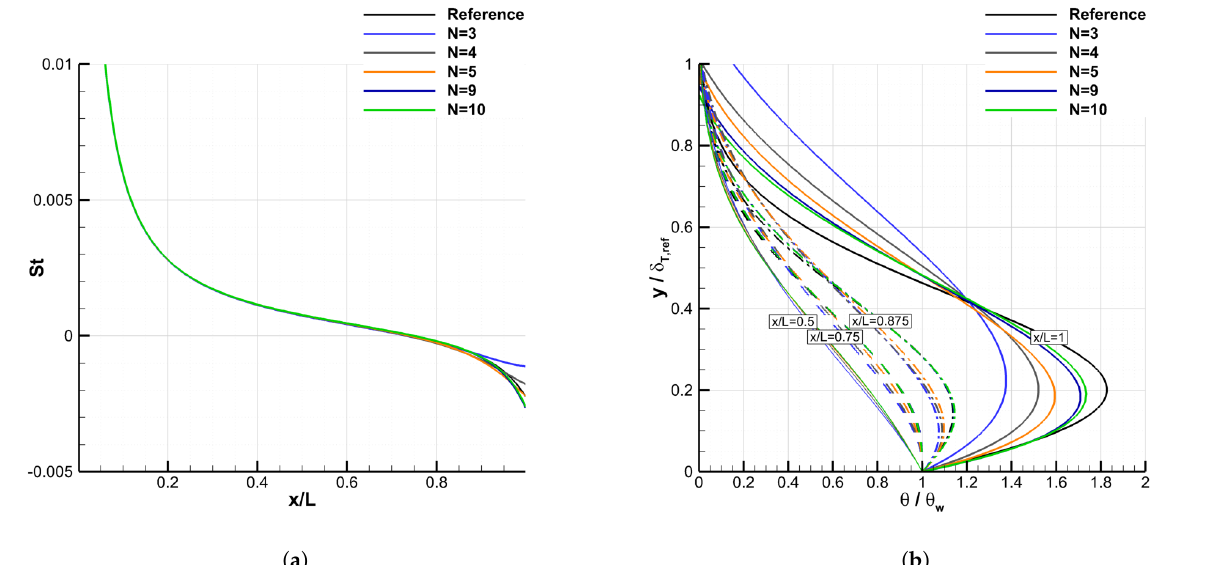
Figure 15. ( a ) Stanton number and ( b ) temperature profiles for several x / L locations. Test case 4, m = 1. N = 3 to N = 10, N x =